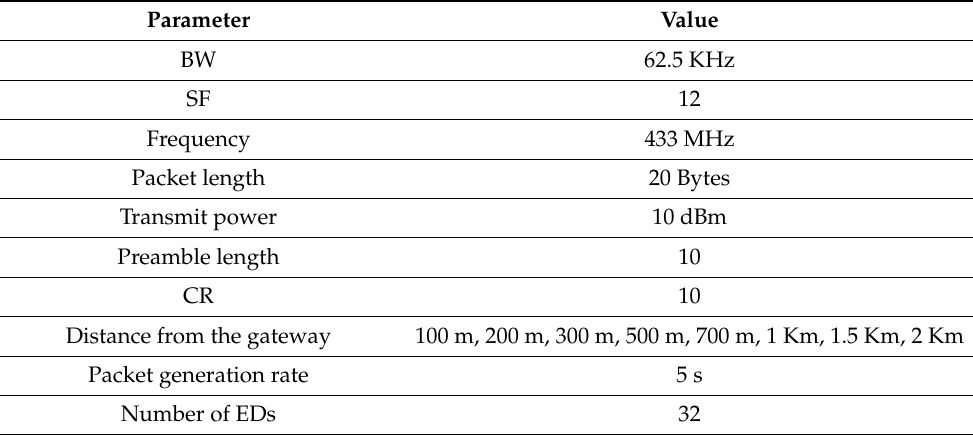
Table 7. Muti-Eds’ initial parameter